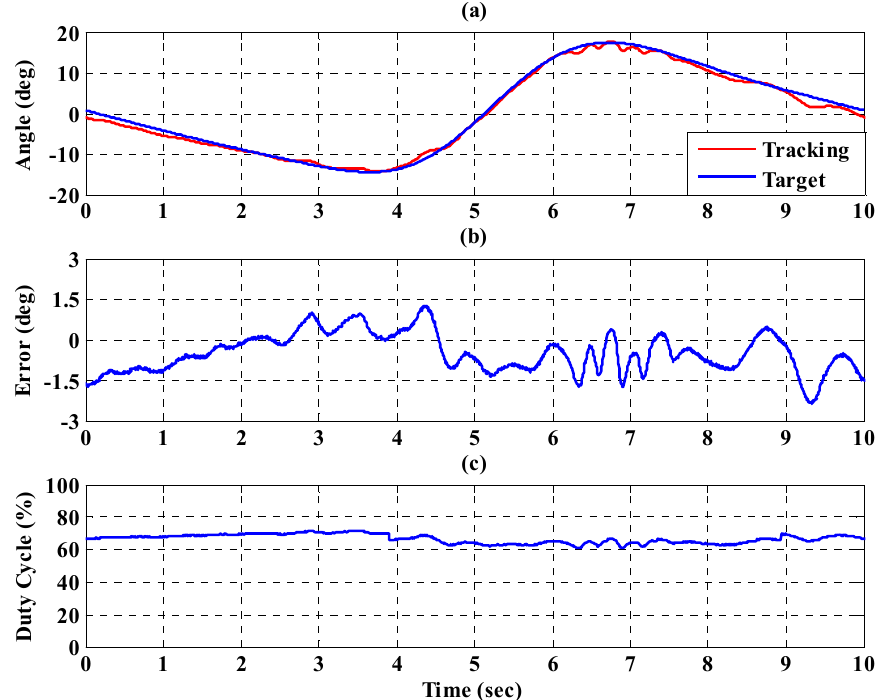
Figure 26. Tracking response of the interval type-2 fuzzy sliding pulse-width modulation controller on the right hip for the PGOS. ( a ) Output response; ( b ) tracking error; ( c ) pulse-width modulation control signal.